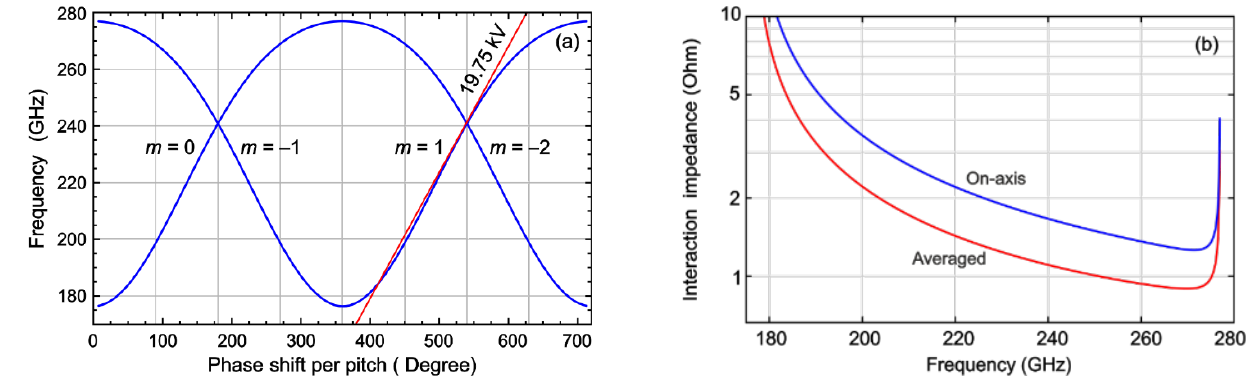
Figure 4. Electromagnetic parameters of the SWS. ( a ) Dispersion diagram (blue lines) and 19.75-kV beam line (red line); ( b ) interaction impedance. On-axis impedance (blue line) and the impedance averaged over the 75 um × 750 um sheet-beam cross-section (red line) are plotted.